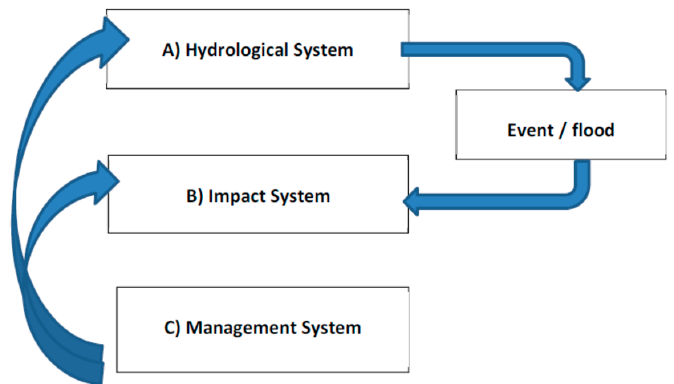
Figure 2. The three systems involved in urban flooding. ( A ) The hydrological system is the terrestrial part of the hydrological cycle with both natural and man ‐ made components; ( B ) The impact system is the part of urban society that may be affected in a detrimental way by a flooding event; ( C ) The management system is the part of urban society that deals with floods in order to decrease the detrimental effects of flood events.